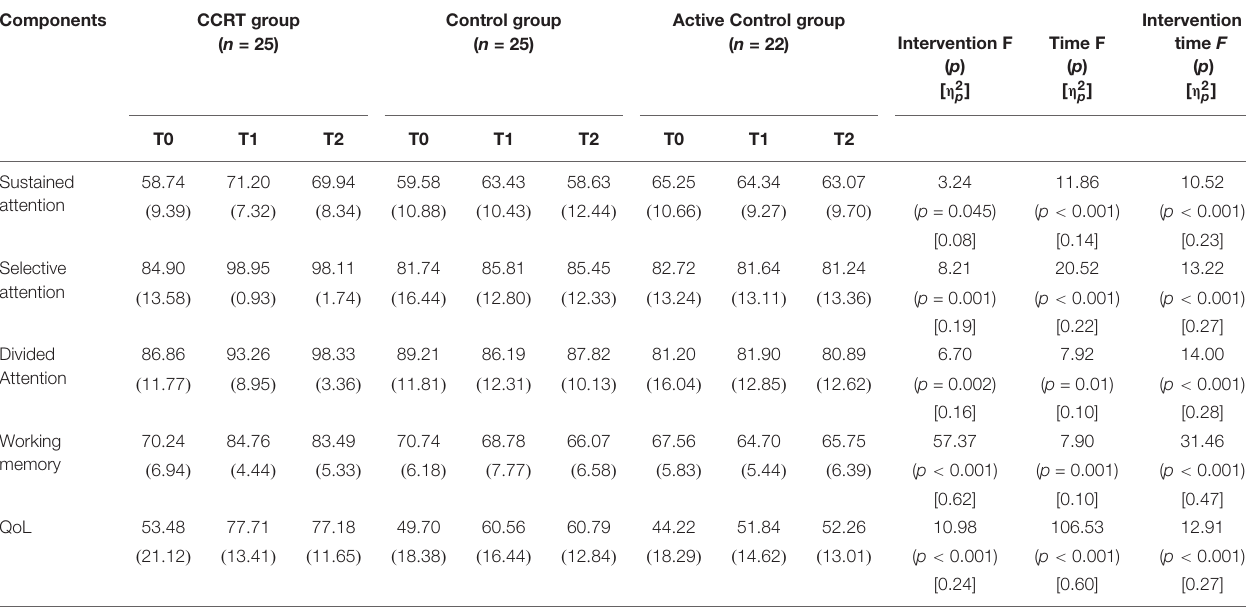
FIGURE 4 | Pre/follow-up correlation between (A) QoL improvement and sustained attention enhancement, (B) QoL improvement and divided attention enhancement, and (C) QoL improvement and working memory enhancement. TABLE 5 | Summary of repeated ANOVA on the entire patients (EM